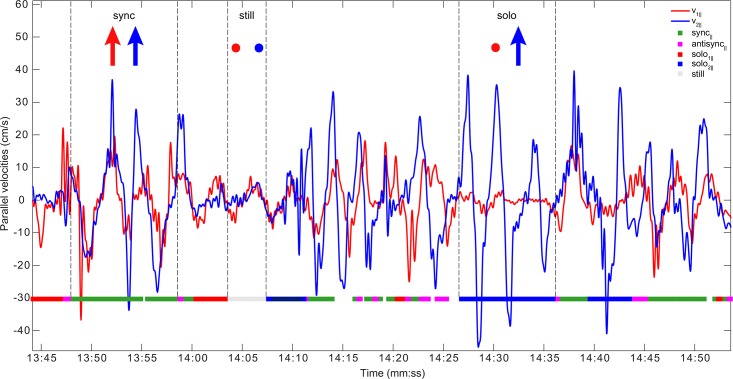
An example of pelvis parallel velocity profiles of two conversing participants from dyad 1.Player 1 (red) and player 2 (blue) parallel pelvis velocity is shown, after the smoothing described in Methods. Motion modes for each moving 2-sec window were classified into pure modes, and color-coded on the horizontal colored bar. Examples of periods of consecutive parallel-sync, mutual stillness and solo motion are indicated (dashed lines and arrows).